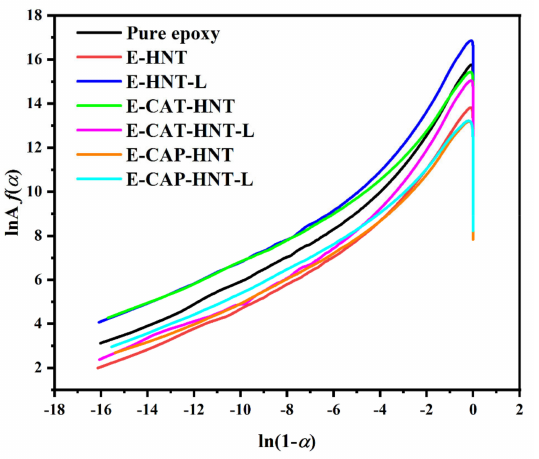
Figure A4. Plots of ln[ Af( α ) ] vs. ln(1 − α ) for the samples at heating rate of 5 ◦ C/min used in calculation of apparent activation energy via Friedman method.